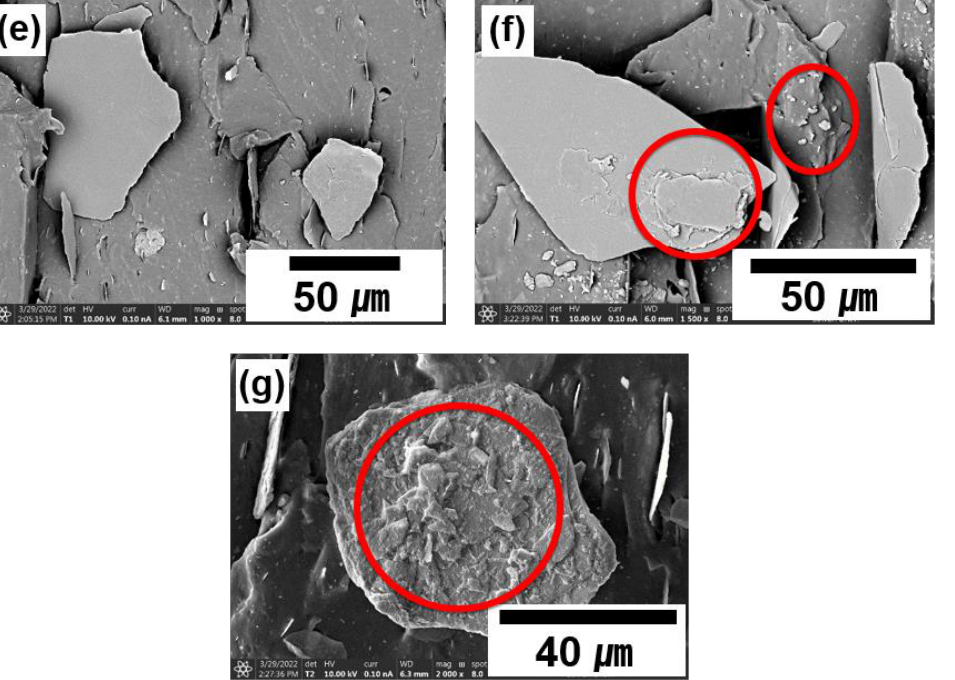
Figure 7. SEM images of fractured NR/EPDM rubber with different fillers (10 phr) and functionalization types (amino- and epoxide-functionalization) for phlogopite: ( a ) None, ( b ) CB, ( c ) silica, ( d ) untreated phlogopite, ( e ) A1S-treated phlogopite, ( f ) A2S-treated phlogopite, and ( g ) ES-treated phlogopite.